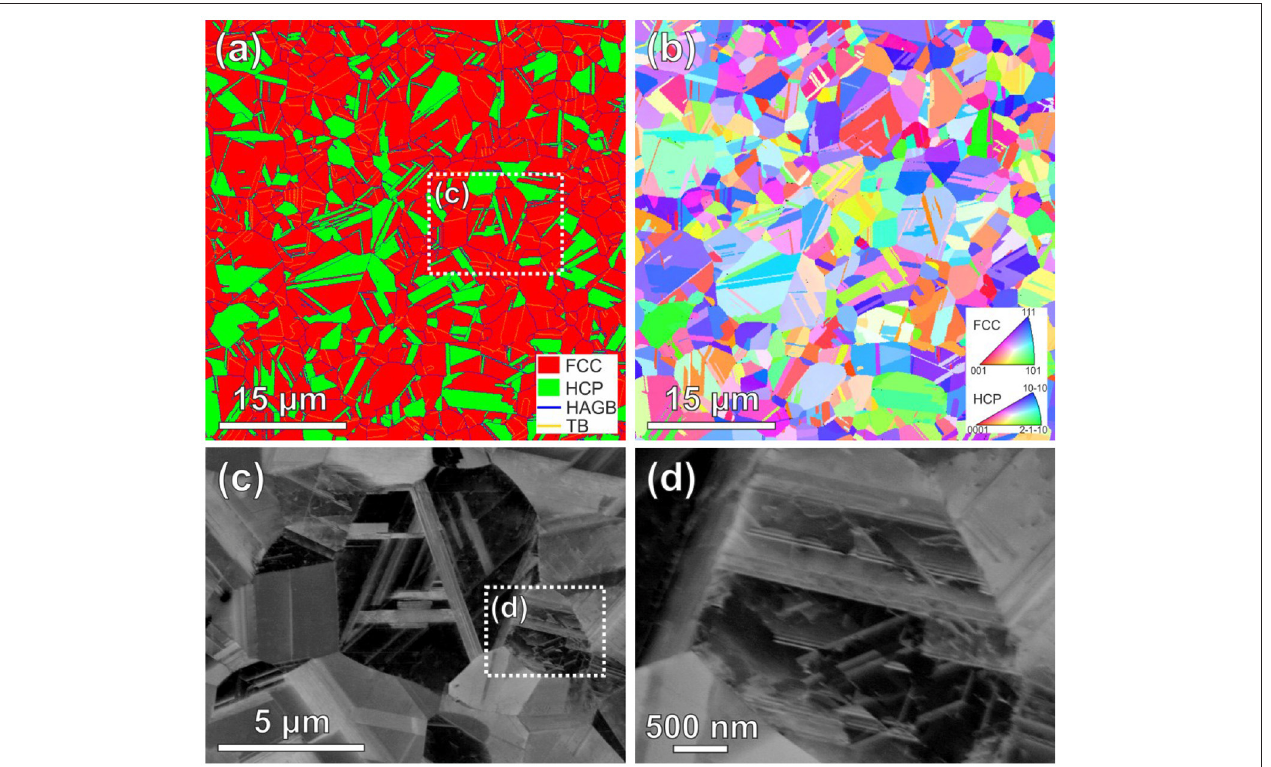
FIGURE 1 | Combined EBSD and ECCI analysis on the fine-grained dual-phase HEA prior to deformation: (a) EBSD phase and boundary map; (b) EBSD IPF map of an identical sample region in (a) ; (c) ECC image of the marked region in (a) ; (d) ECC image of the marked region in (c) with relatively high magnification showing stacking faults in the FCC